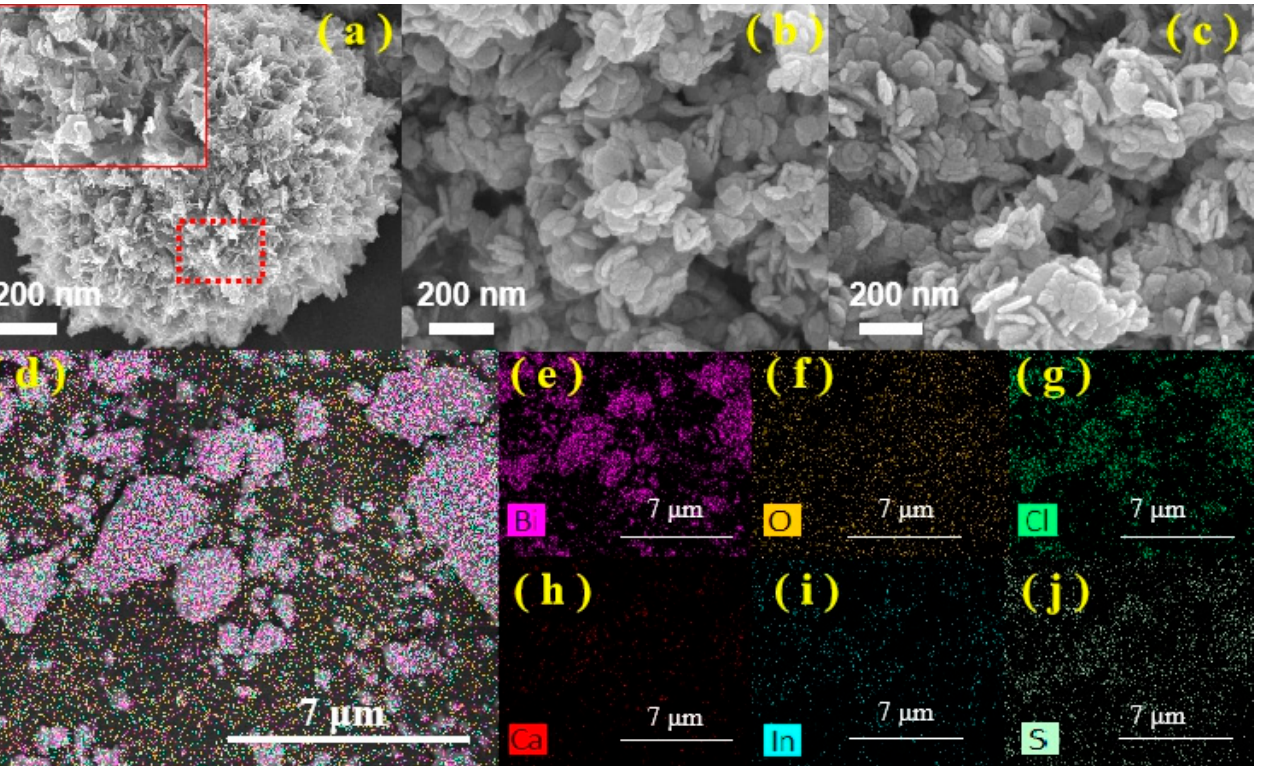
Figure 4. SEM images ( a ) pure CaIn 2 S 4 , ( b ) pure BiOCl, ( c ) 1% CIS/BOC-SOVs, ( d – j ) EDX of 1% CIS/BOC-SOVs.